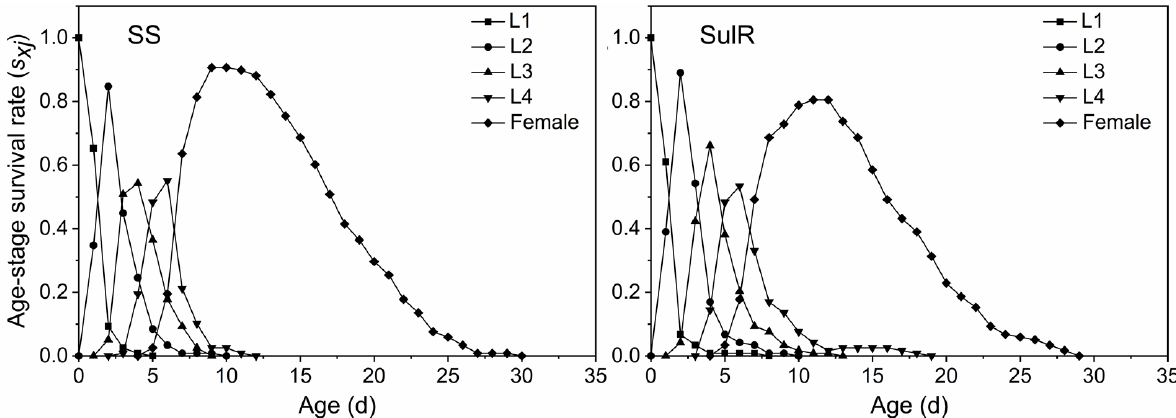
Figure 1. Age-stage-specific survival rate ( s xj ) of sulfoxaflor-resistant (SulR) and sulfoxaflor-suscep- tible (SS) Sitobion miscanthi populations. L1, first nymph stage; L2, second nymph stage; L3, third